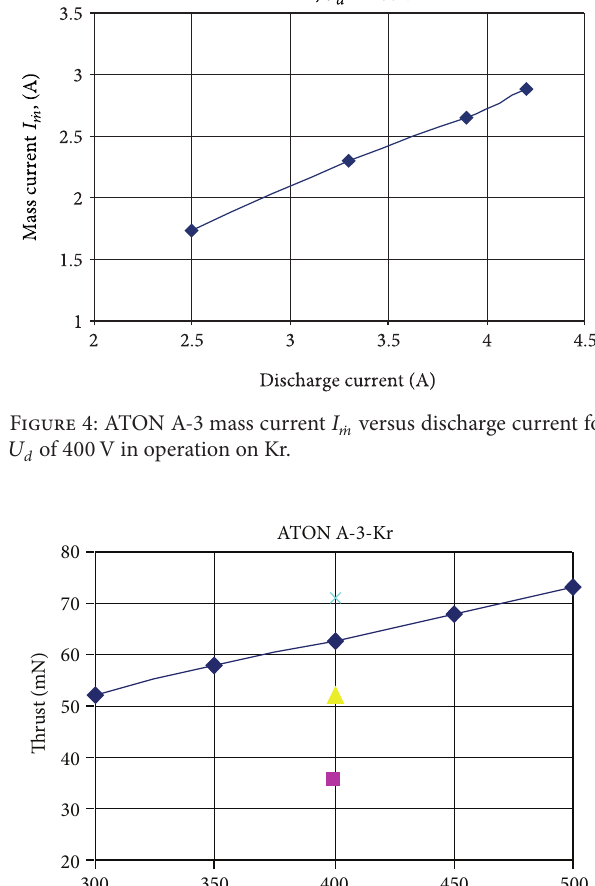
Figure 3: ATON A-3 discharge current versus discharge voltage under ̇𝑚 𝑎 = 2.3 mg/s and for different Kr anode mass flow rates under 𝑈 𝑑 = 400 V.